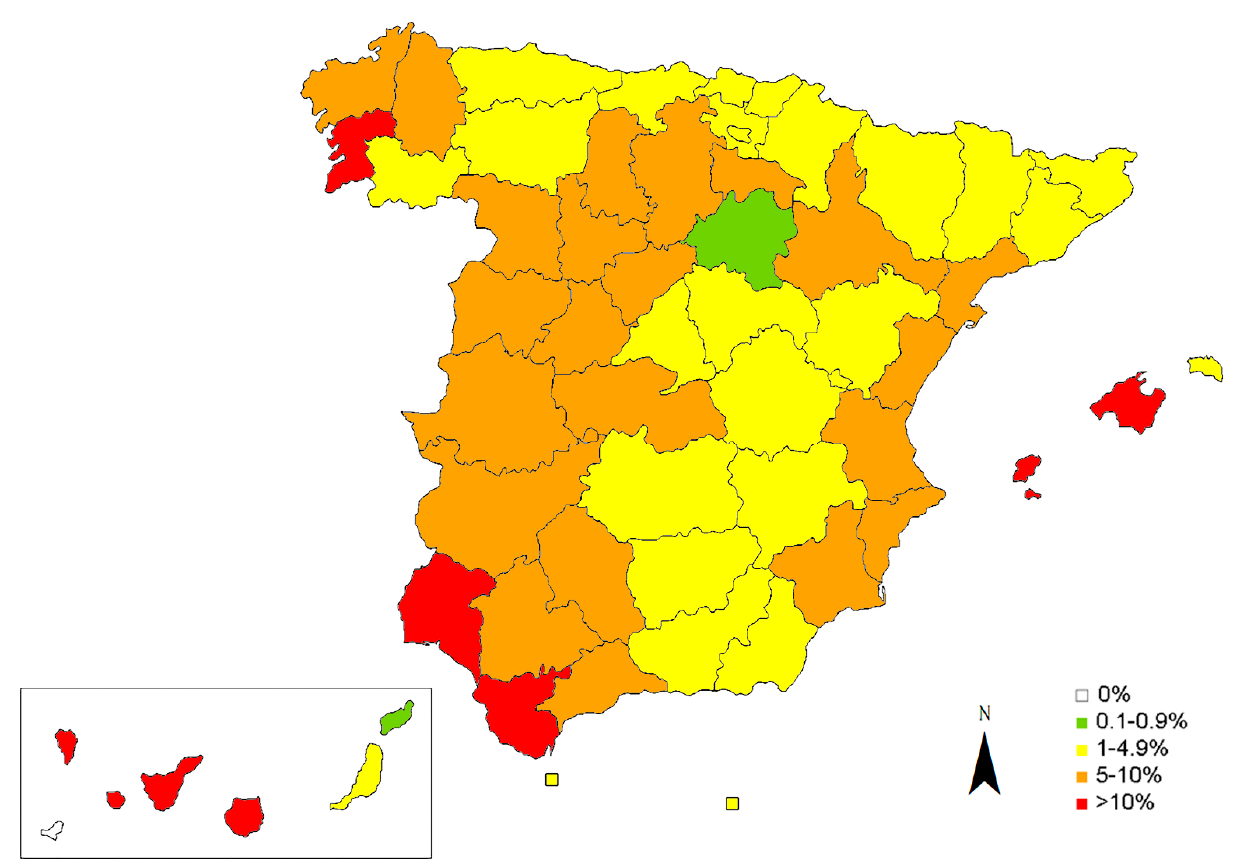
Figure 2. Prevalence map for D. immitis in domestic dogs in Spain by provinces, islands and the autonomous cities.